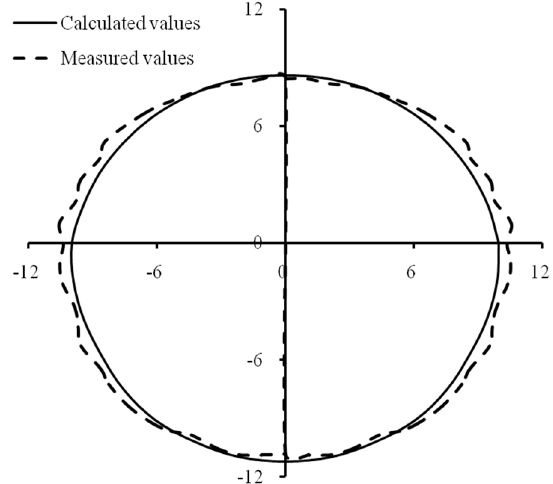
Figure 6. Comparison of measured and calculated values of throw radius at pulsating pressure on sloping ground. Notes: the positive and negative vertical axis represent the uphill and downhill slope direction, respectively. The horizontal and vertical axes are both in meters.